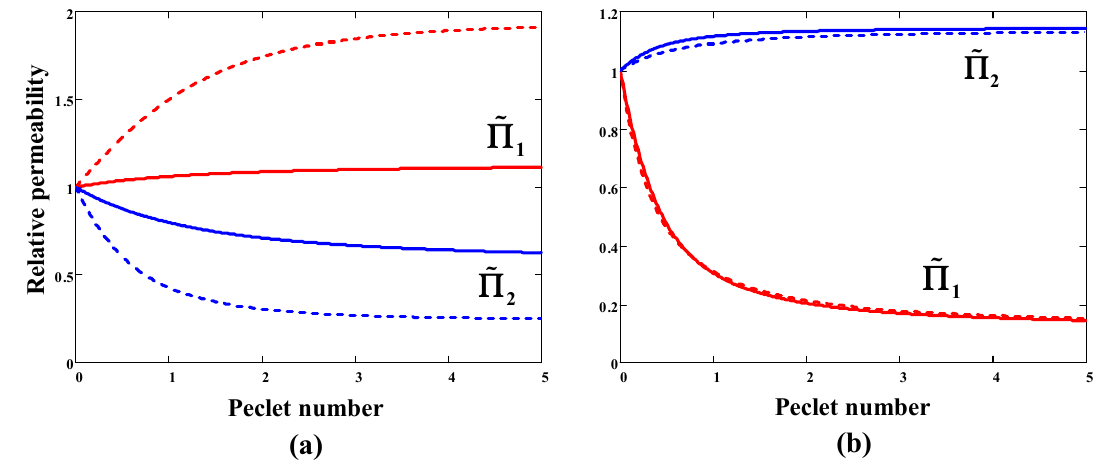
Figure 2. Calculated permeability of component 1 (red lines) and component 2 (blue lines) for the binary gas mixture (molar fraction x 1 = 0.1) with the ideal selectivity α 12 = 15 as a function of the membrane Pecl é t number: ( a ) sorption-selective membrane ( α S = 30, α D = 0.5); ( b ) diffusion-selective membrane ( α S = 1.5, α D = 10). Solid lines: the pressure ratio r = 0, dotted lines: r = 0.1.